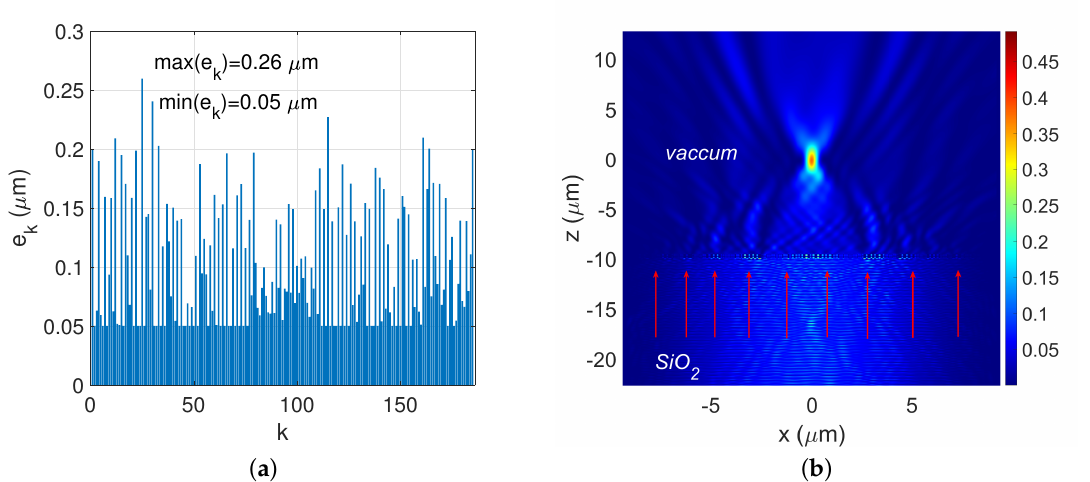
Figure 6. Design of a plasmonic silver-flat-metalens of d = 18.75 µ m-wide consisting of N p = 185 silver-nanoridges and air-gap focusing a normal incident TM-polarized plane wave at a wavelength λ = 0.637 µ m at a distance of 15 λ . ( a ) shows the values of the (nanorodes, nanoslits)-widths sequence [ e k ] k with respect to their locations labelled by k . ( b ) presents the cartography of the normalized magnetic field’s intensity in the plane ( X , O , Z ) . Numerical parameters: λ = 0.637 µ m, N p = 52, e z = 400 nm, TM polarization. ( a ) | H y ( x 0 , z ) | 2 /